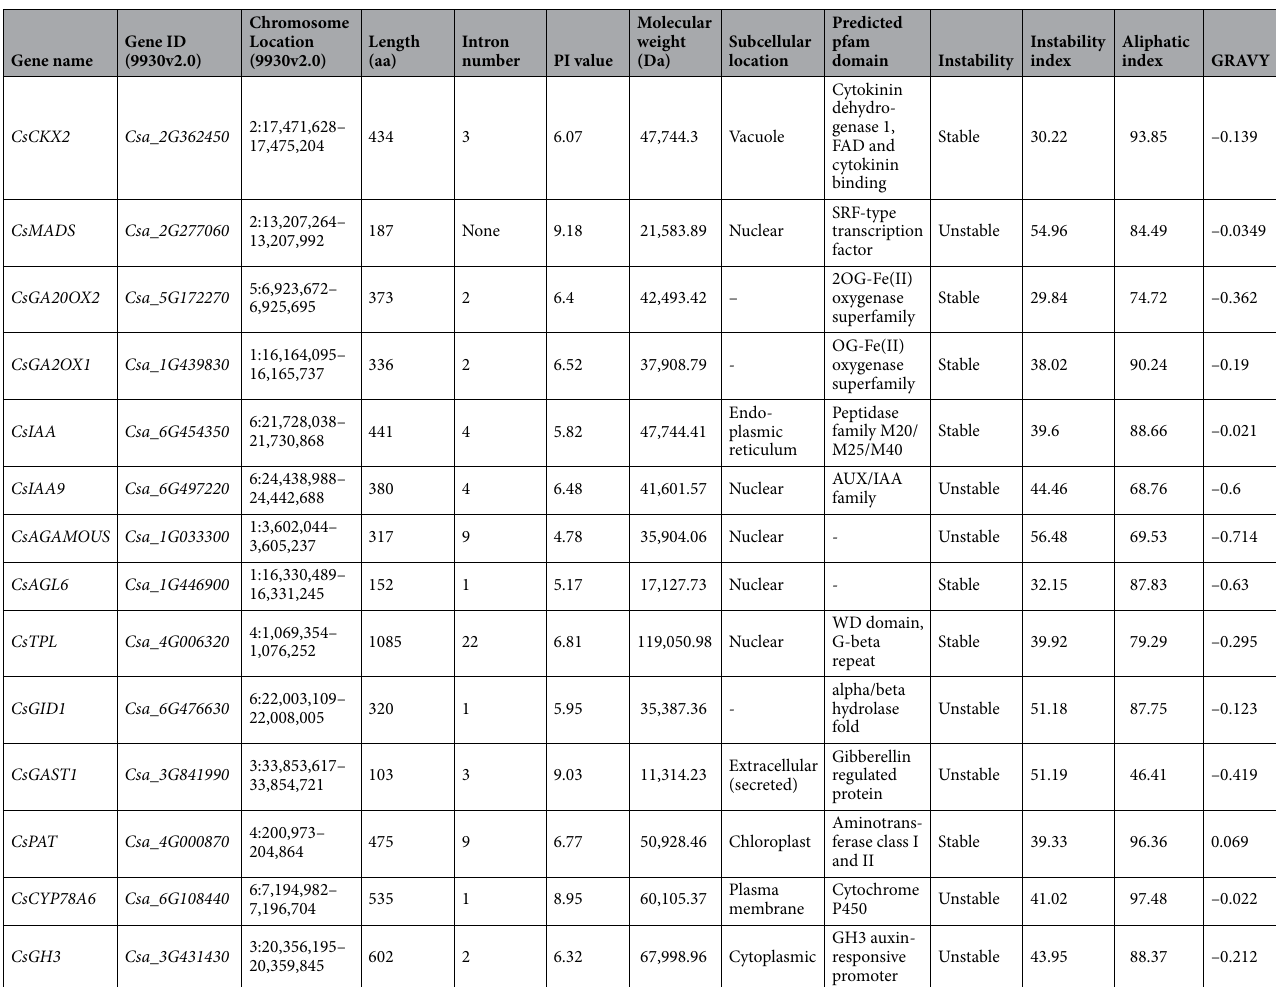
Table 1. Physical and chemical properties of PRG